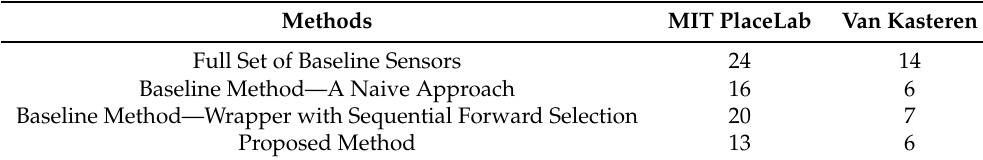
Table 5. Number of sensors selected by each